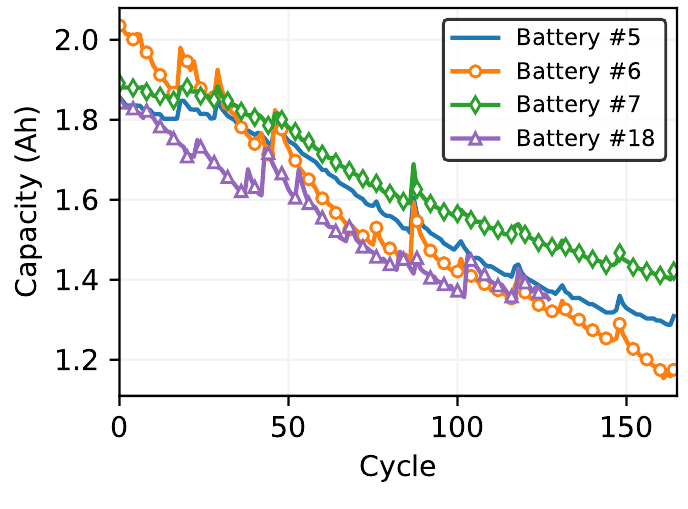
Figure 1. Lithium-ion battery degradation with respect to number of